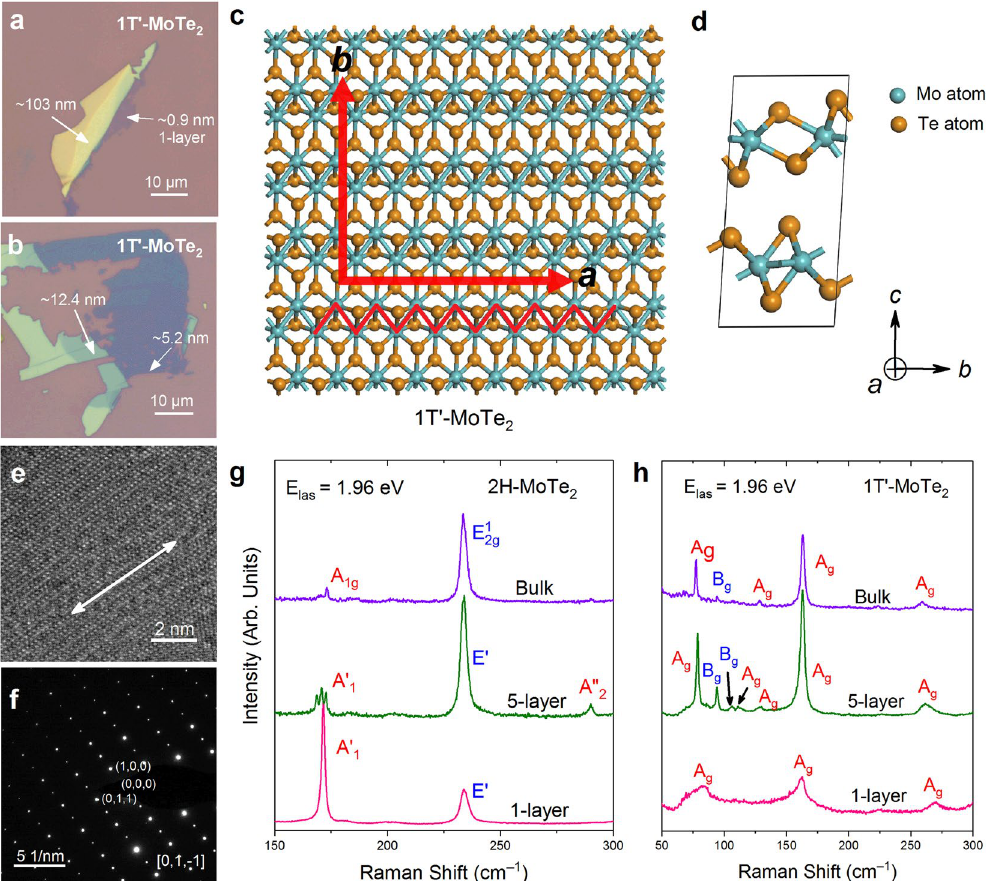
Figure 1. ( a,b ) The optical images of exfoliated single-layer and few-layer 1 T´-MoTe 2 on a 285 nm SiO 2 /Si substrates. The thicknesses of the flakes are labeled. ( c ) The top view crystal structure of single-layer 1 T´-MoTe 2 . The zigzag metal chains, a -axis and b -axis are labeled. ( d ) The side view unit cells of 1 T´-MoTe 2 . ( e ) The high- resolution TEM image of few-layer 1 T´-MoTe 2 , where the direction of Mo-Mo chain is represented by a white double-headed arrow. ( f ) The selected electron diffraction image of 1 T´-MoTe 2 flakes top-viewed from the [01- 1] zone. ( g , h ) The representative 1 T´-MoTe 2 and 2H-MoTe 2 Raman spectra of 1-layer, 5-layer, and